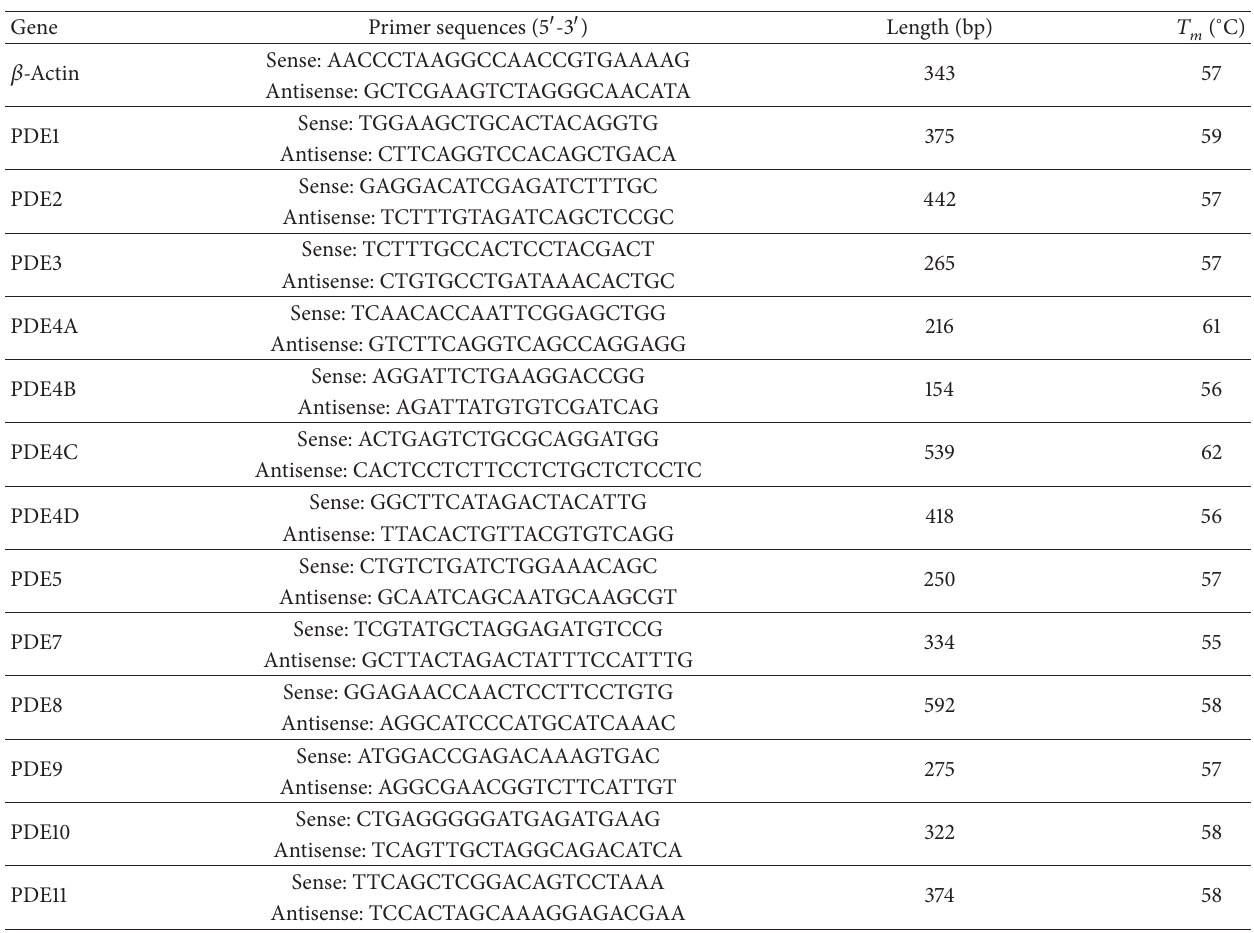
Table 1: Primer sequences of rats